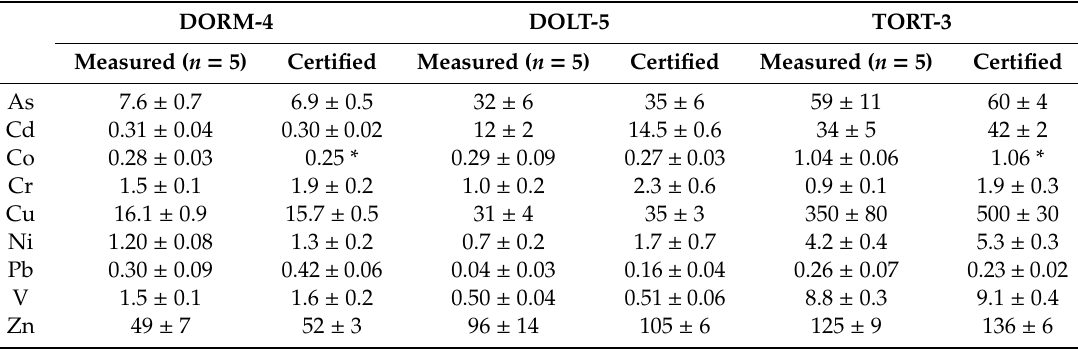
Table 1. Determination of elemental concentrations (in µ g.g − 1 , dry material), compared to certified values for reference materials from NRCC: DORM-4 (fish protein), DOLT-5 (dogfish liver), and TORT-3 (lobster hepatopancreas). DORM-4 DOLT-5